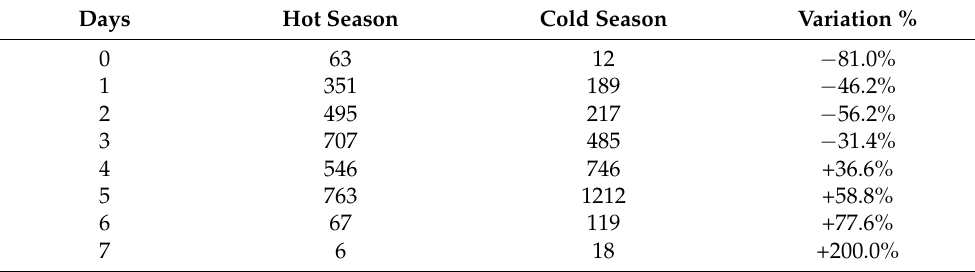
Table 4. Percentage variations from hot to cold season.